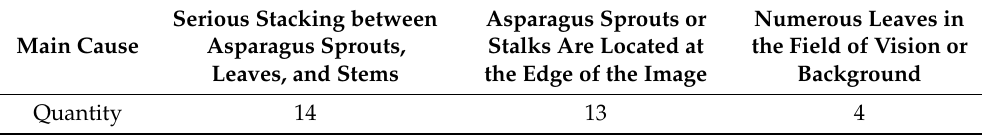
Table 7. Statistics of the main reasons for detection